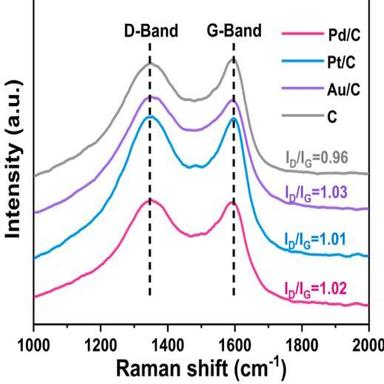
Raman spectra of C, Pd/C, Pt/C, and Au/C.